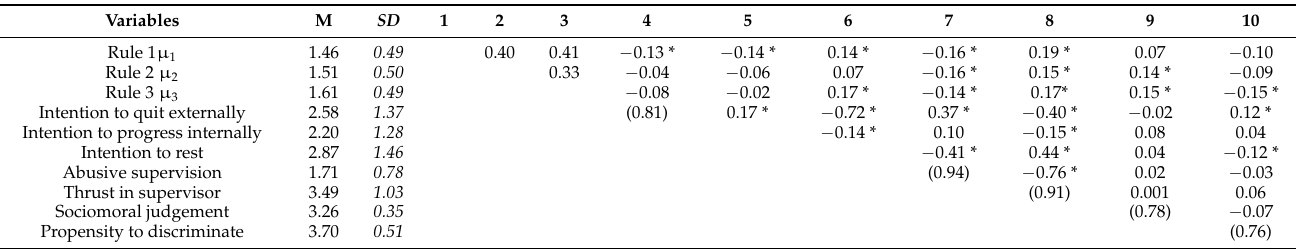
Table 1. Correlation matrix between all variables (Alpha de Cronbach between brakets).